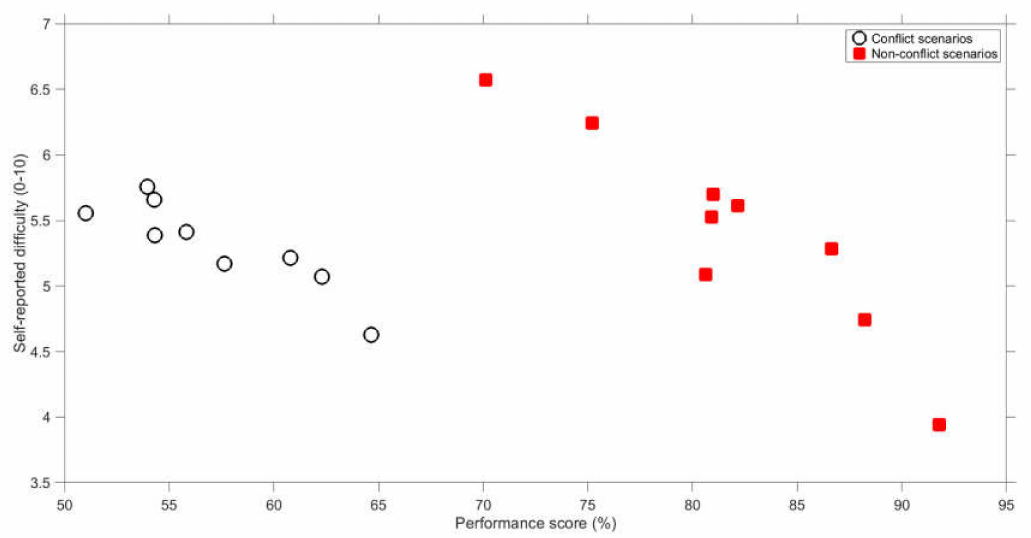
Figure 12. Mean self-reported di ffi culty score versus mean performance score for conflict scenarios and non-conflict scenarios. Each marker represents the average of 35 participants and 2 scenarios (discrete and continuous scenarios are